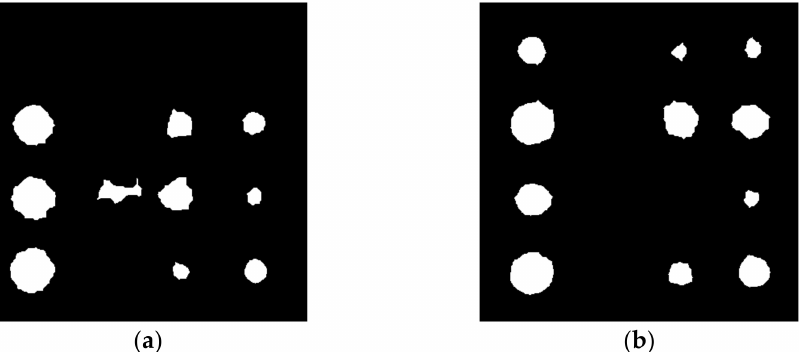
Figure 10. Images with second de-noising applied after the binarization process: ( a ) amplitude and ( b )